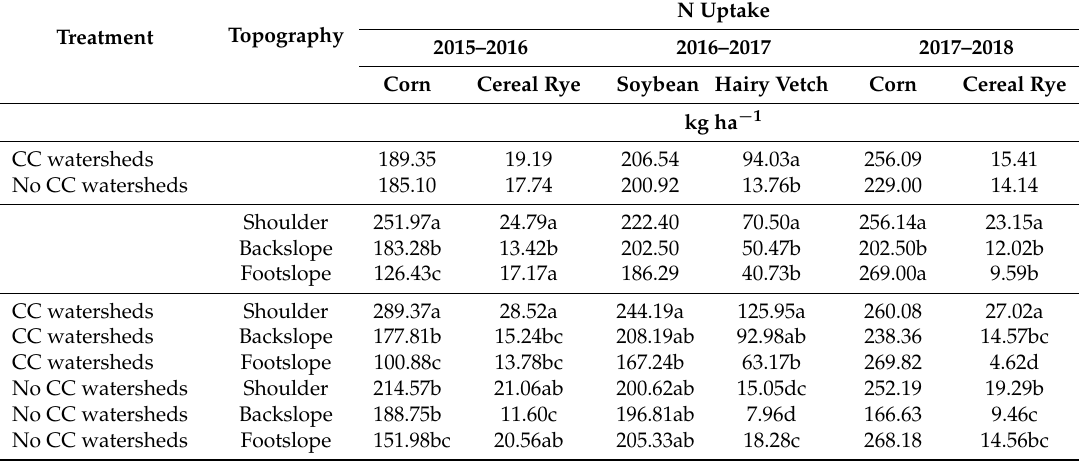
Table 5. Nitrogen uptake (kg ha − 1 ) of cover crop (CC) + weeds and cash crops (corn/soybean) determined by CC treatment and topography. Within a column and within a given factor or combination of factors, means followed by the same letter are not statistically different ( α = 0.05). N Treatment Topography